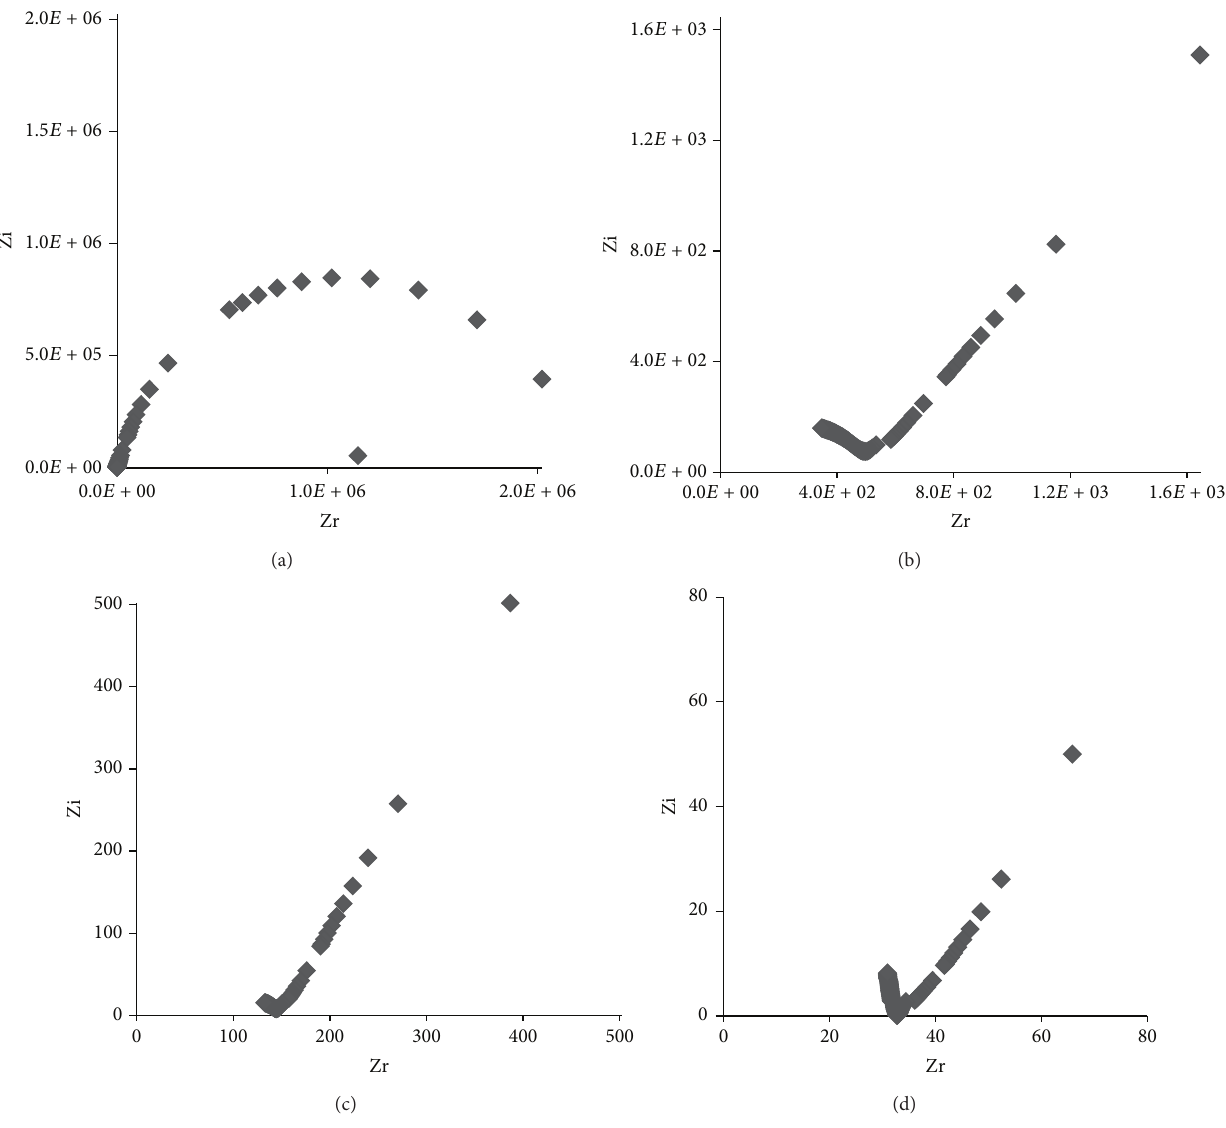
Figure 1: Cole-Cole plot for SPE samples: (a) PEO; (b) (PEO/LiCF 3 SO 3 ); (c) (PEO/LiCF 3 SO 3 /DBP); (d) (PEO/LiCF 3 SO 3 /DBP/ZrO 2 ) at ambient